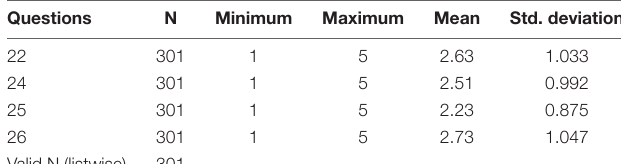
TABLE 14 | Frequency and percent of the questions related to the learners’ technology literacy in technology integration learning environments. Questions